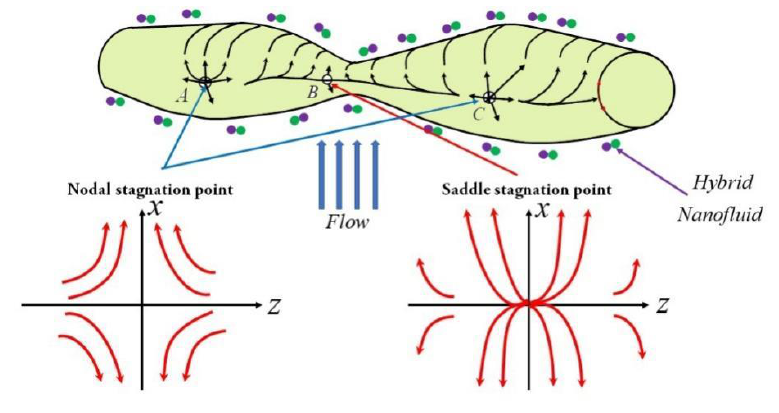
Figure 1. Geometry of the problem.